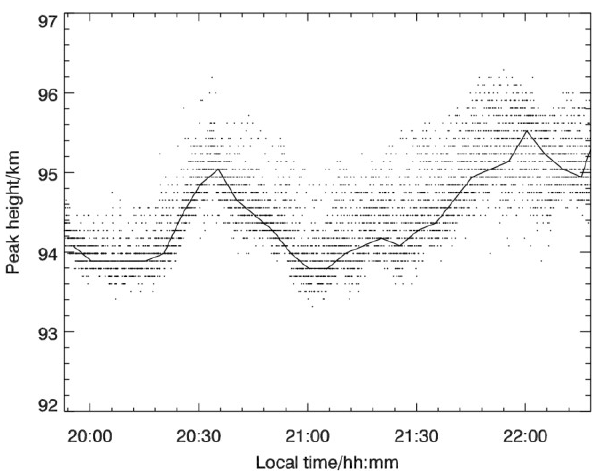
Fig. 2. Peak height variations of Na s layer shown in Fig. 1 observed at different time resolutions. The dots show the data with 1.5s reso- lution and the solid line shows the same data with 5min resolution.